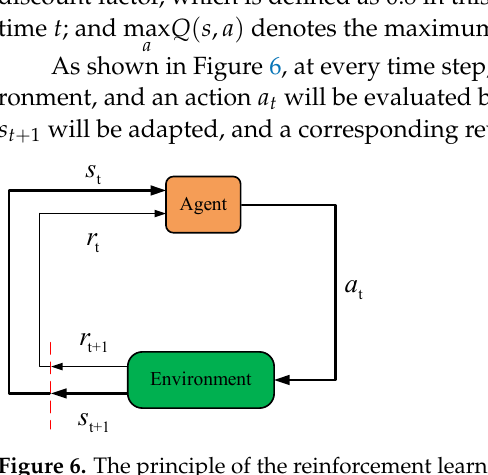
Figure 7. The principle of the RL-based energy management. (1) The state As stated above, the difference between the feedback SOC and the reference SOC is defined as the sole state, which is descried as f ref t s SOC SOC = − (9) where f SOC denotes the feedback SOC. The state